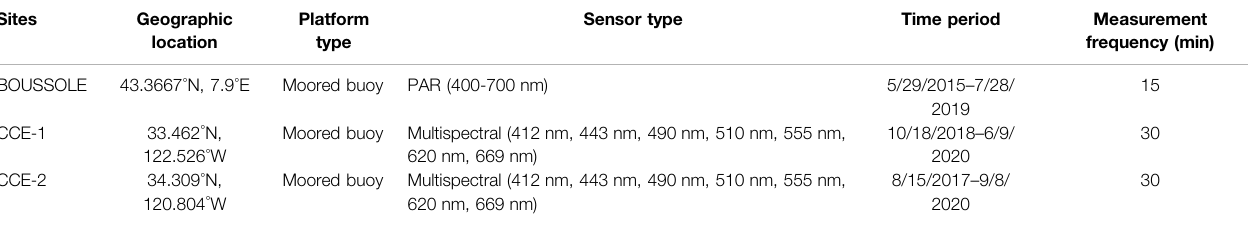
TABLE 2 | I Characteristics of the in situ above surface downward solar irradiance datasets used in the evaluation of the EPIC < E PAR > estimates.